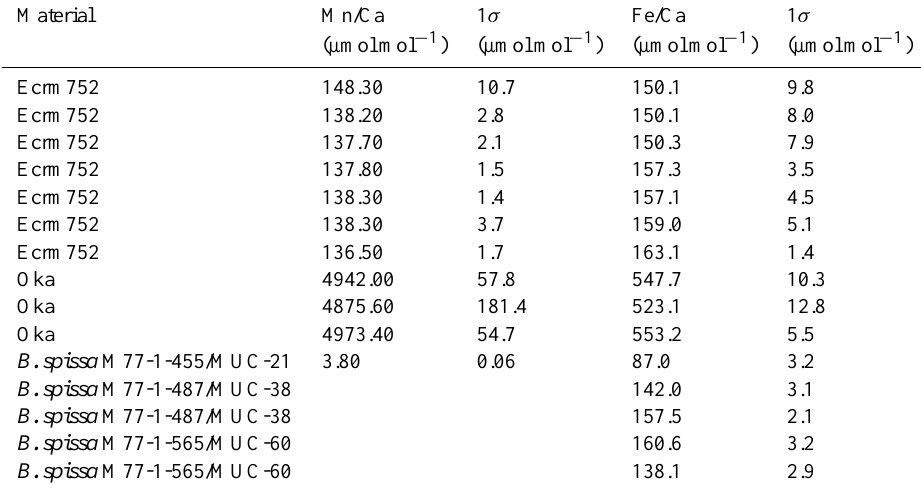
Table 2. Element/Ca ratios for different samples determined by ICP-MS.